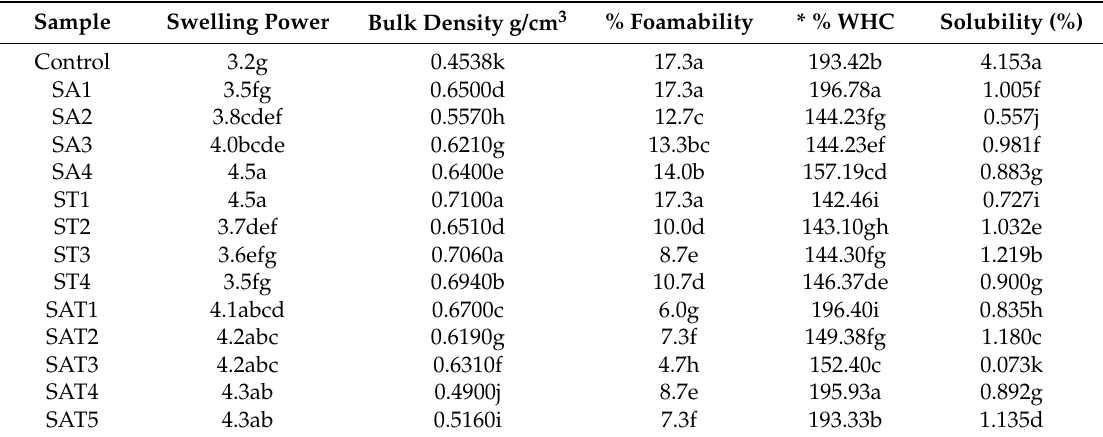
Table 5. Functional properties of the formulated composite